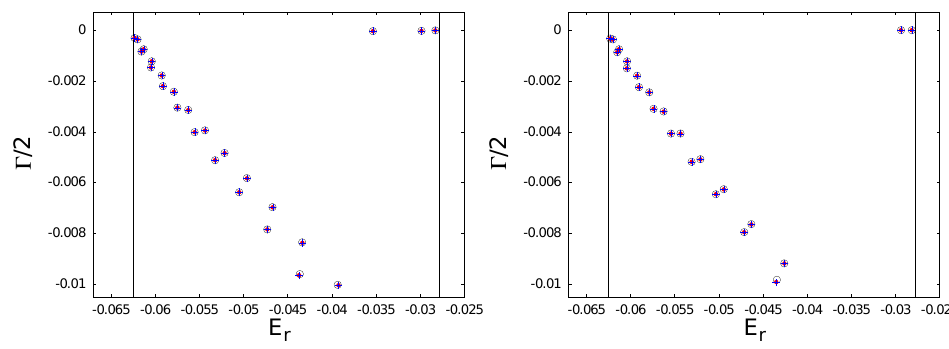
Figure 7. 1 S and 3 S resonances of the e − Ps system between the n = 2 and n = 3 thresholds. Black circles indicate data using cut-off parameters x 0 = 12, y 0 = 30, red dots indicate data using cut-off parameters x 0 = 15, y 0 = 35, and blue + symbols indicate data using cut-off parameters x 0 = 15, y 0 = 30. Thresholds indicated with vertical